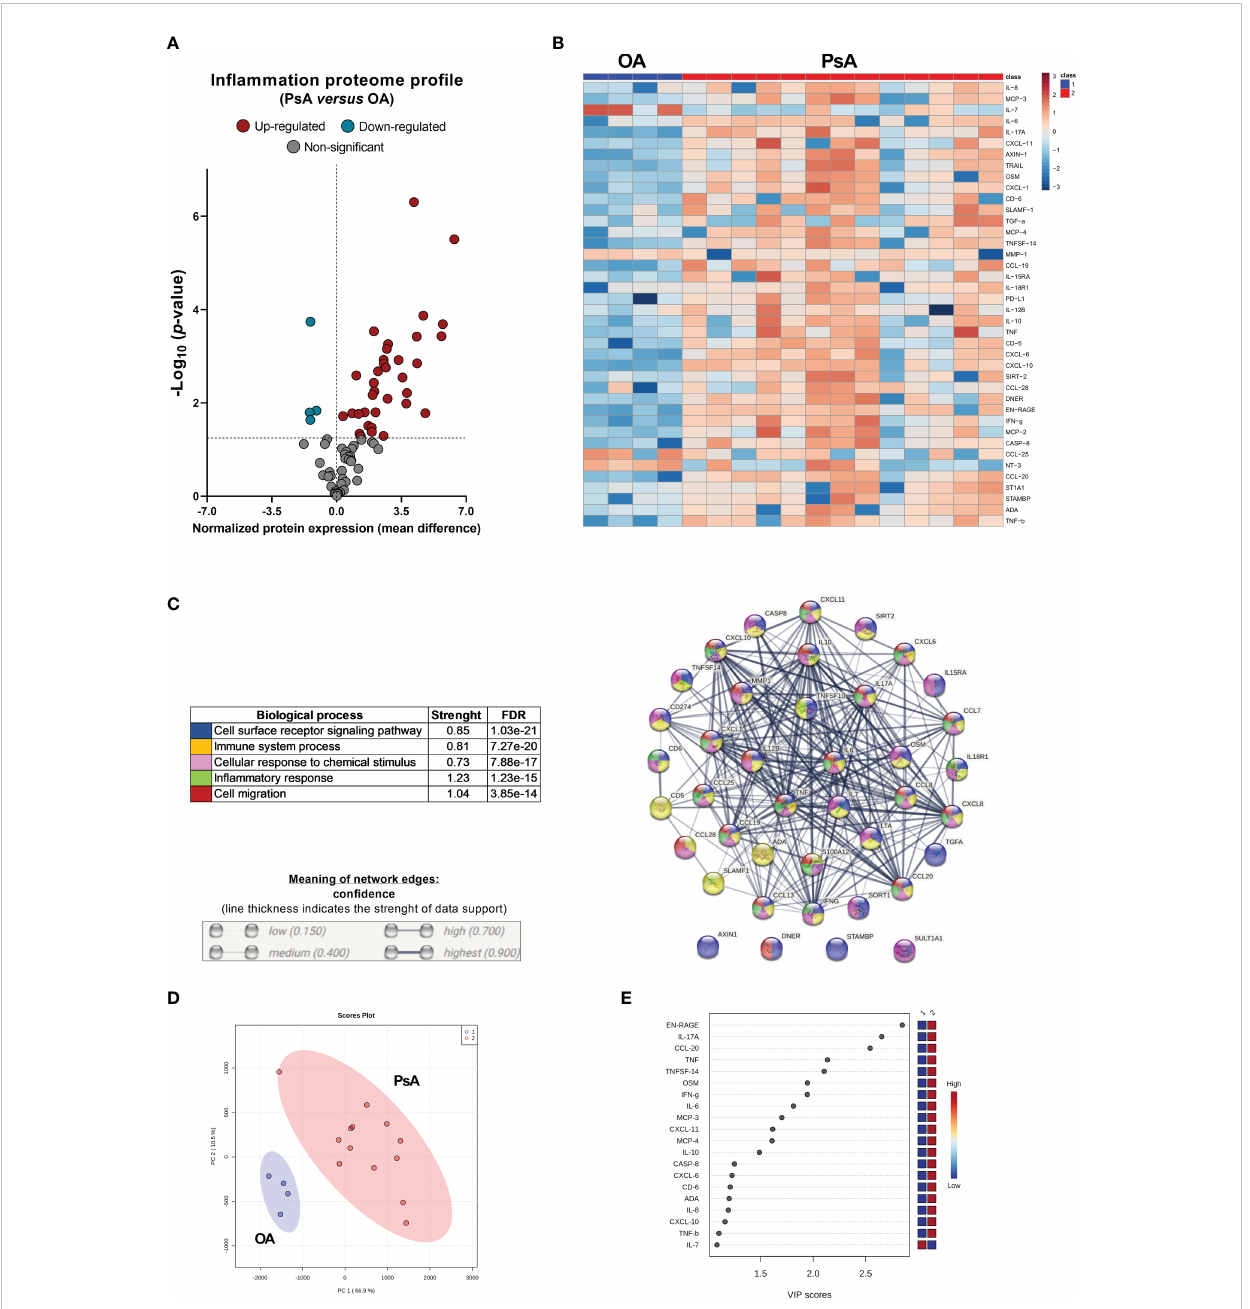
FIGURE 2 PsA synovial fl uid show a signi fi cant alteration of the in fl ammatory proteome in relation to osteoarthritis (OA). (A) Volcano plot of 92 in fl ammation- related proteins in PsA compared to OA. (B) Heatmap of signi fi cant proteins altered in PsA compared to OA. (C) Functional classi fi cation of the altered levels of the in fl ammatory proteome in PsA by STRING platform. (D) Principal component analysis (PCA) summarizing the differences in the molecular pro fi le of each group. (E) The most contributing proteins to discriminate PsA compared to OA